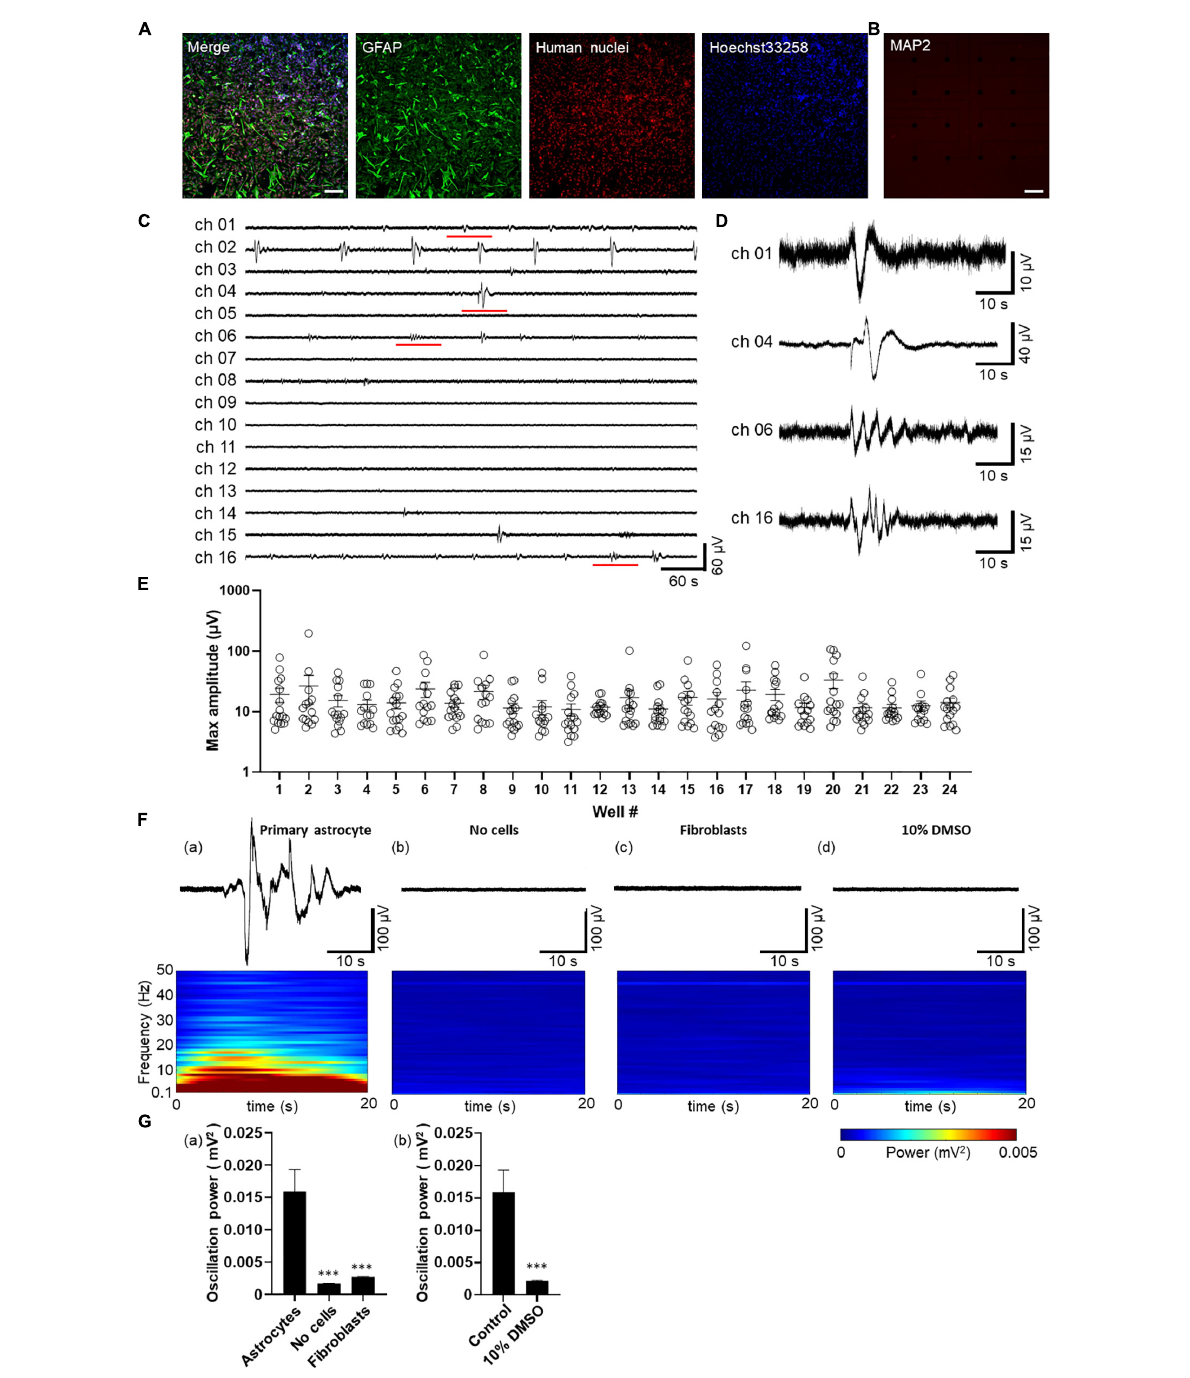
FIGURE1 Spontaneous activity in human primary astrocytes detected by MEA. (A,B) Immunofluorescent images of astrocytes cultured on MEA at 8 days in vitro (8 DIV). Immunocytochemistry of GFAP (green), human nuclei (red), cell nuclei by Hoechst 33,258 (blue), merged images in A , and MAP2 (red) in (B) Scale bar = 200 µ m. (C) Representative oscillation waveform at the spontaneous activity measurement for 10 min at 7 DIV. (D) The magnified waveform of the red underlined time in (C) . (E) Plot of maximum amplitude in 10 min oscillation waveform of each well. Error bars indicate the SEM. (F) Waveforms (upper panel) and their power spectrogram (lower panel) at maximum spectral intensity. (a) astrocytes, (b) no cells, (c) fibroblasts, (d) after 10% DMSO treatment. The vertical axis of the spectrogram shows the linear frequency from 0.1 Hz to 50 Hz, and the color indicates power. A 20 s spectrogram was extracted from the 40 s waveform. (G) Oscillation power of the control experiments. (a) Human primary astrocytes, no cells, fibroblasts, and (b) human primary astrocytes before and after 10% DMSO treatment. unpaired two-tailed t -tests, ∗∗∗ p < 0.001 versus astrocytes. Error bar,